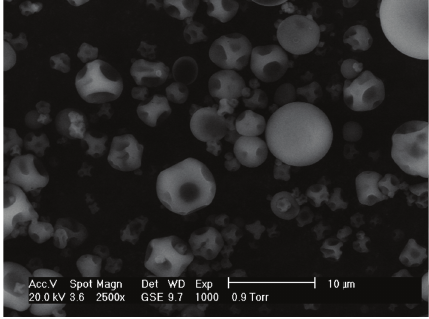
Figure 1: Micrograph of microencapsulated oregano EO, by spray drying. Magnification is 2,500x. Table 2: Headspace volatile compounds identified from microcapsules of Lippia graveolens H.B.K. and Origanum vulgare L. essential oils by headspace